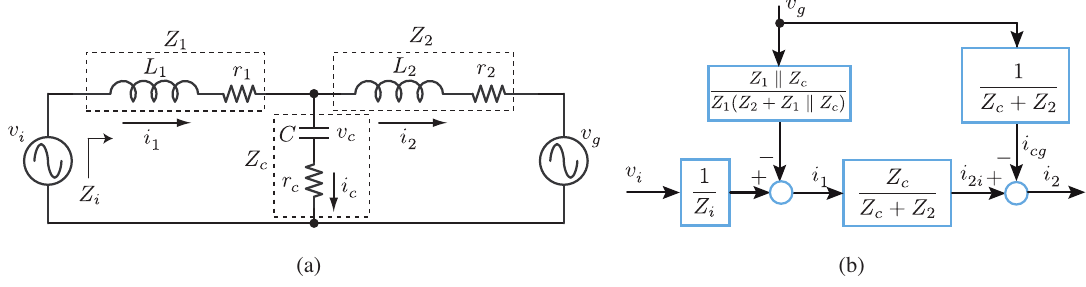
Figure 2. LCL filter model in the αβ reference frame: ( a ) circuital and ( b ) block diagram